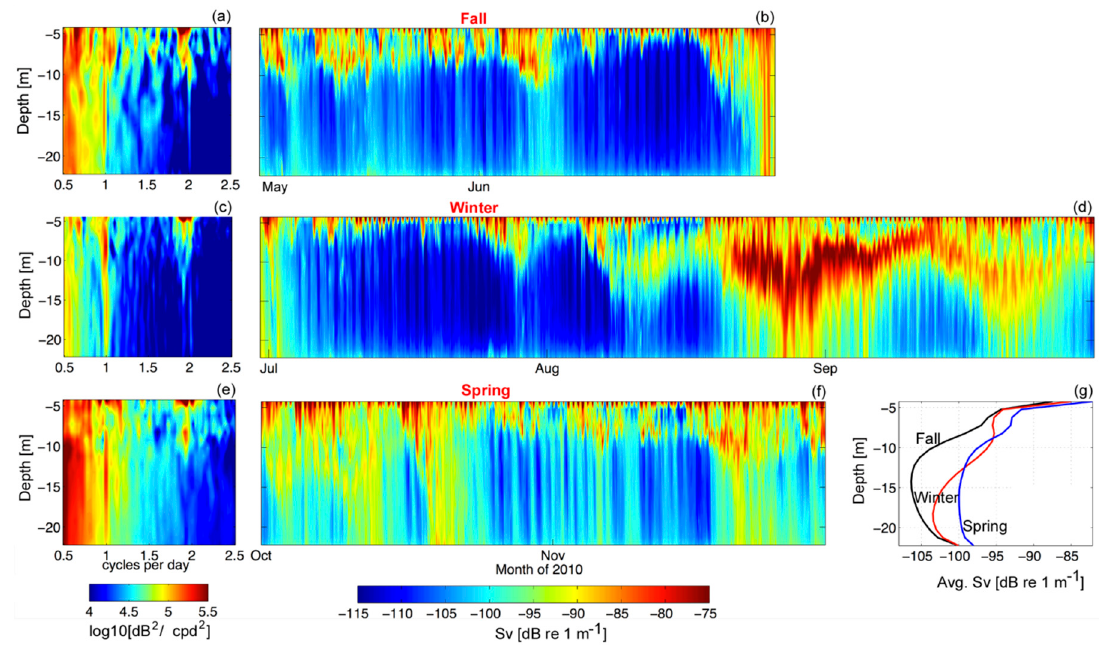
Figure 5. ( a ) Spectra of the autumn time series of S v (log 10 (dB 2 /cpd 2 )), ( b ) is the autumn S v time series. ( c ) and ( d ) are the same as ( a ) and ( b ) for the winter time series. ( e ) and ( f ) are the same as ( a ) and ( b ) for the spring time series. ( g ) Time averages of S v for each season.